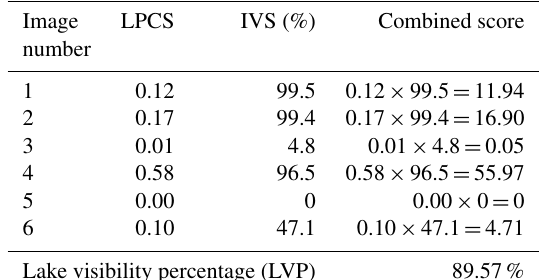
Table 1. Example data highlighting how pixel contribution scores and their corresponding visibility scores are combined to create an overall “lake visibility percentage” for each time window. The Landsat images used in this example are displayed in Fig. S5 in the